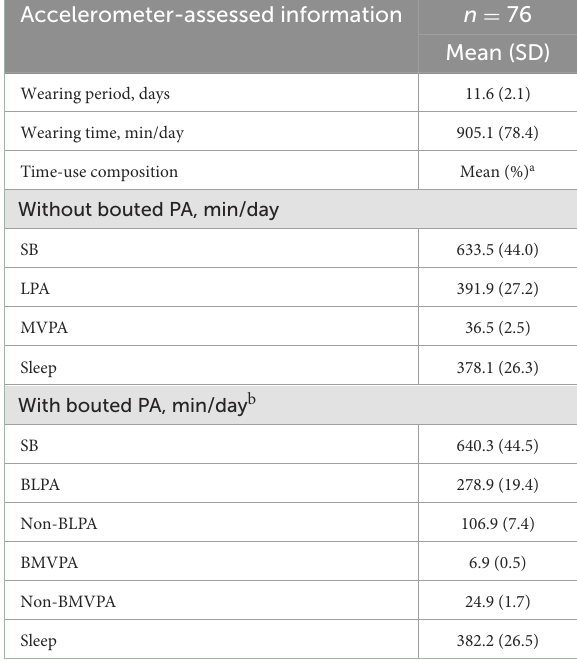
TABLE 1 Characteristics of movement behaviors in the study participants. Accelerometer-assessed